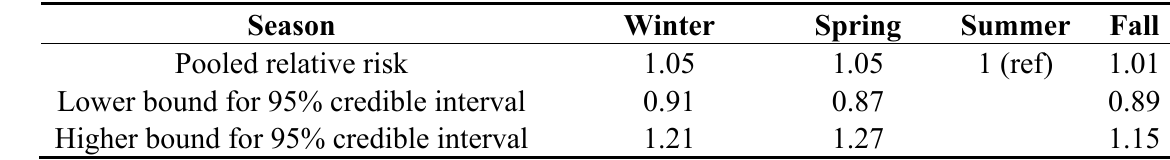
Table A6. Pooled relative risks and 95% credible interval for the association between season of birth on preeclampsia